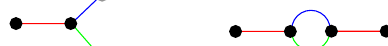
and (cid:101) O M . (a) Part of the k k